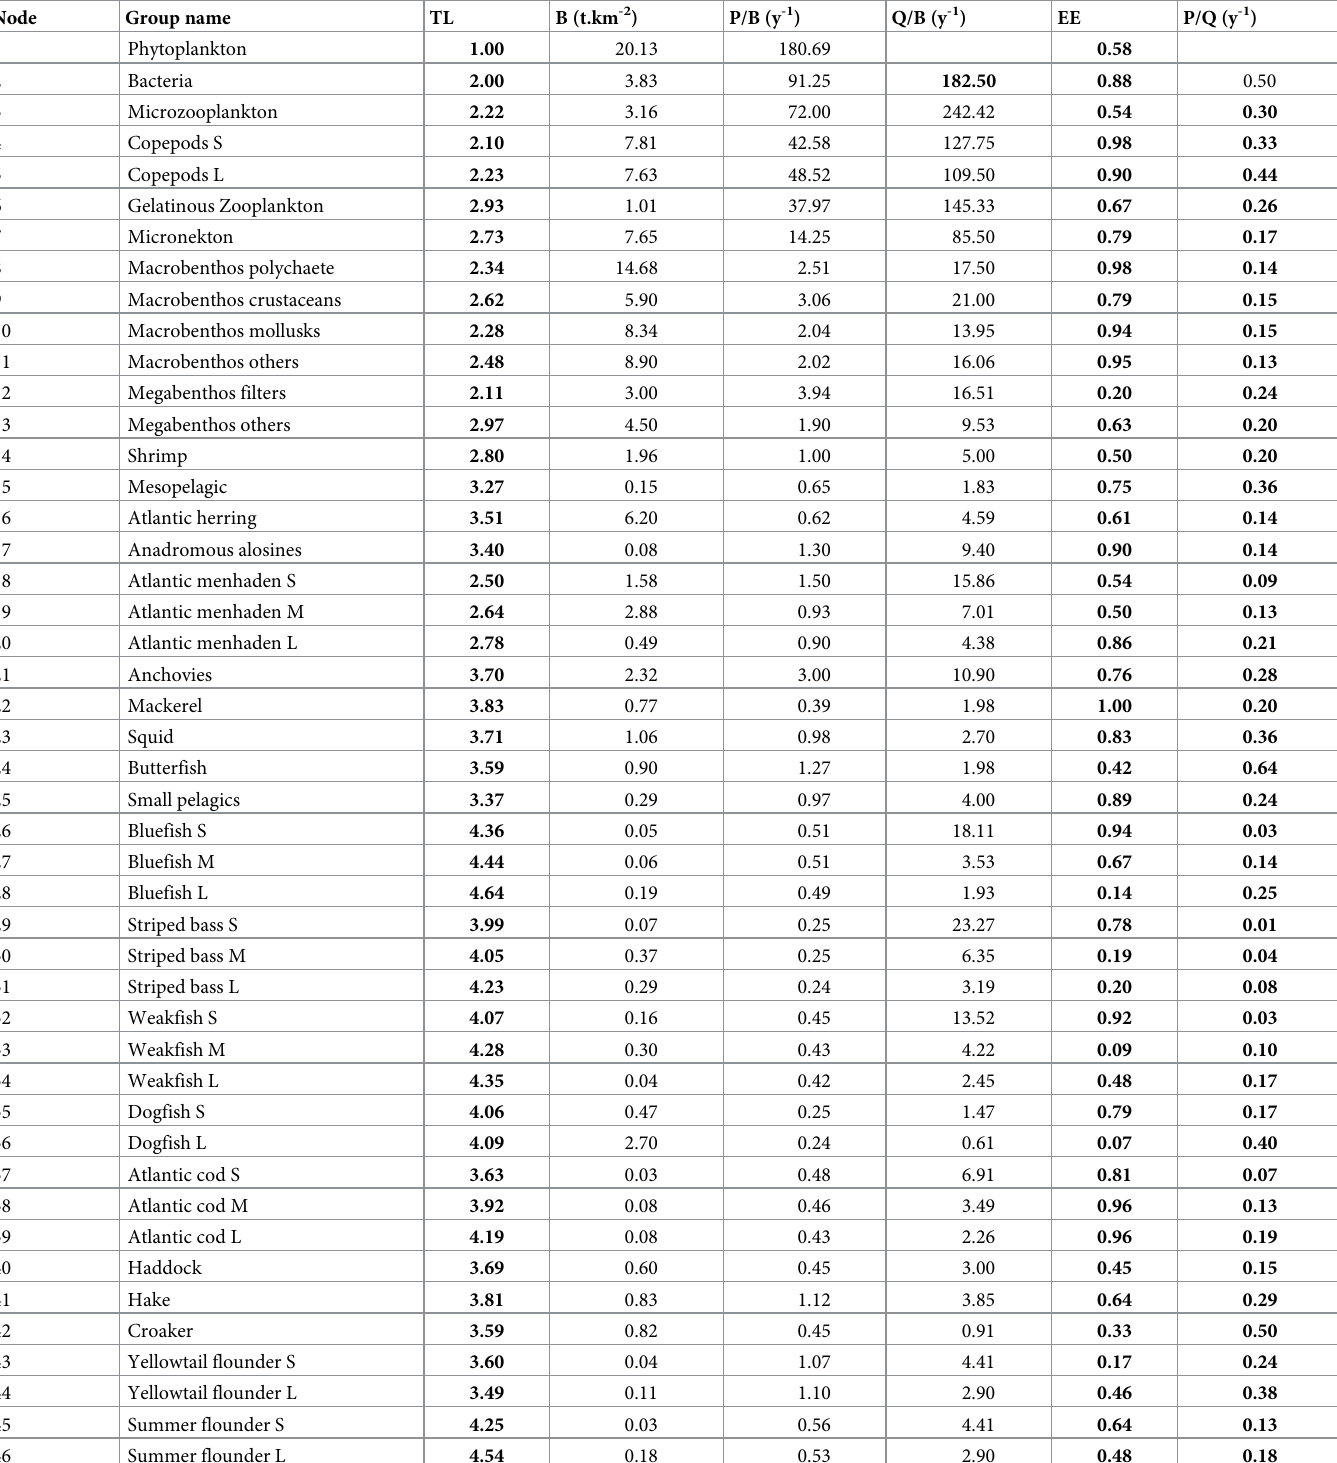
Table 1. Functional groups input parameters sources for the Contemporary Alosine Biomass (CAB) model for the NEUS LME. Inputs parameters are Biomass (B), the production-biomass ratio (P/B) and the consumption-biomass ratio (Q/B), output parameters calculated by EwE are Trophic level (TL), Ecotrophic Efficiency (EE) and the production-consumption ratio (P/Q), signaled in bold. Input data documentation is found in the S1